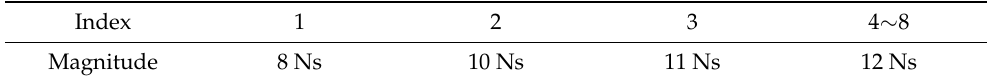
Figure 6. The balancing behavior in push recovery scenario along the X axis ( a ) and the Y axis ( b ). For the push recovery along the X axis, the index and magnitude of impulses are listed in Table 2. Table 2. The magnitude of impulses along the X